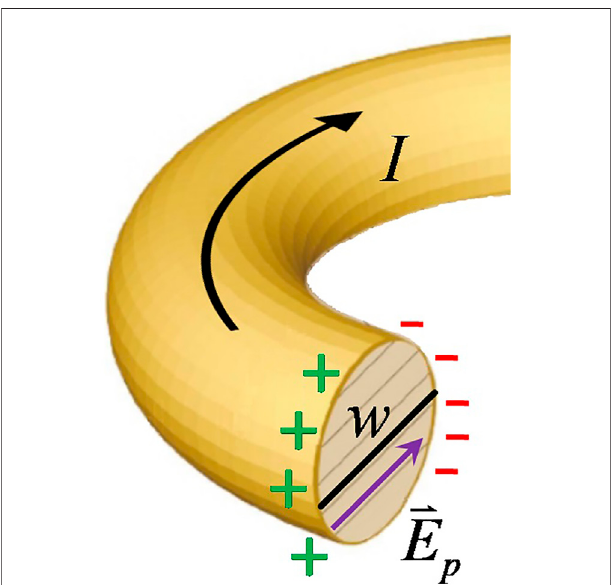
FIGURE 2 | A polarization electric fi eld, (cid:2) Ep , occurs as a result of the supercurrent I inthepresence of (cid:2) B G .Thewidthofthecross-sectionofthering is w , and a corresponding Hall potential, V H = wE p , would exist between the inner and outer surface of the